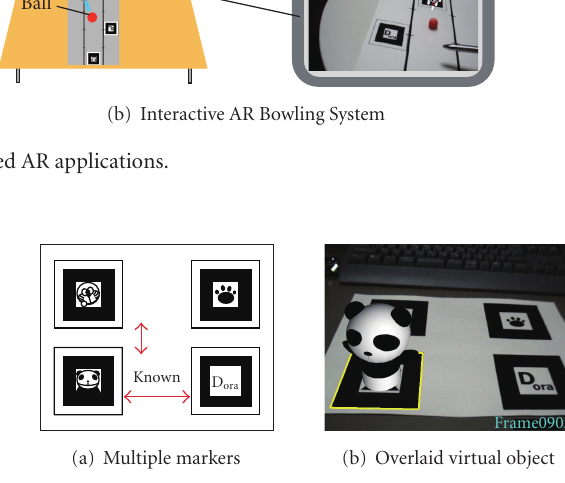
Figure 2: Usual multiple marker-based registration of a virtual